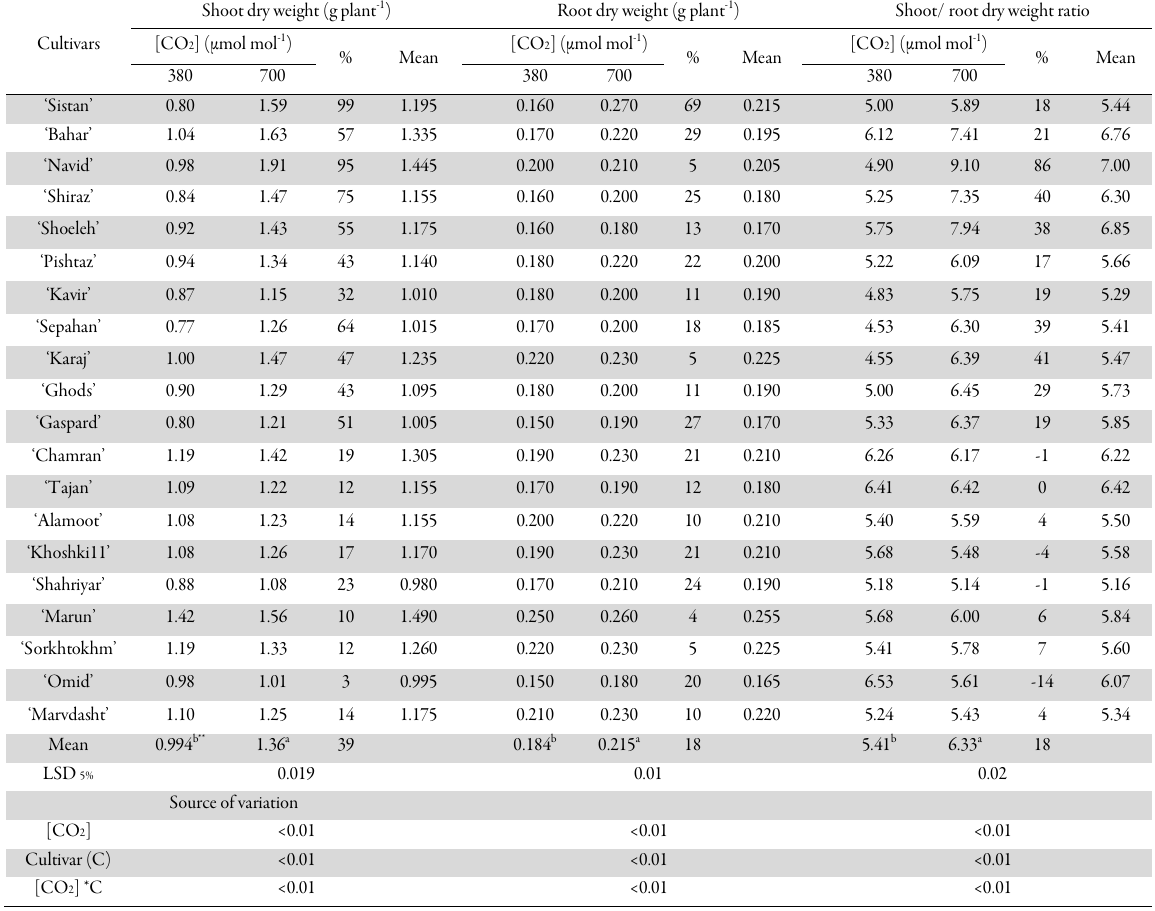
Table 5 . Effects of two [CO 2 ] (380 ± 50 vs. 700 ± 50 µmol mol -1 ) on shoot (g plant -1 ), root (g plant -1 ) and shoot/ root dry weight ratio of 20 Iranian bread wheat cultivars